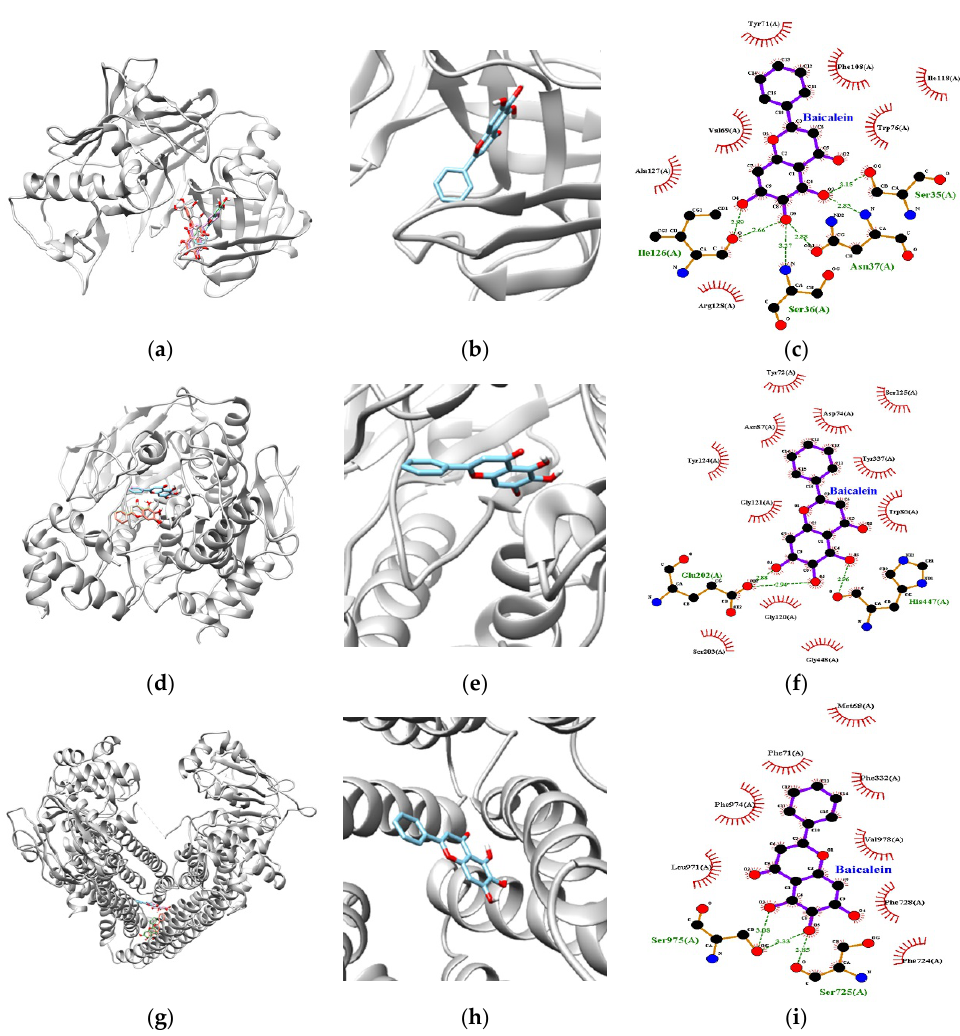
Figure 3. Docking simulation of the structure for BACE1, AChE, and P-gp with baicalein. The best docking poses between BACE1, AChE, and P-gp and baicalein ( a , d , g ). View of the binding site magnified from baicalein ( b , e , h ). 2D ligand interaction diagrams of BACE1, AChE, and P-gp inhibition by baicalein ( c , f , i ). Green dotted lines indicate H-bonds. Non-ligand residues involved in hydrophobic interactions are marked with open spokes. Atoms are colored as follows; carbon atoms in black, nitrogen atoms in blue, and oxygen atoms in red.